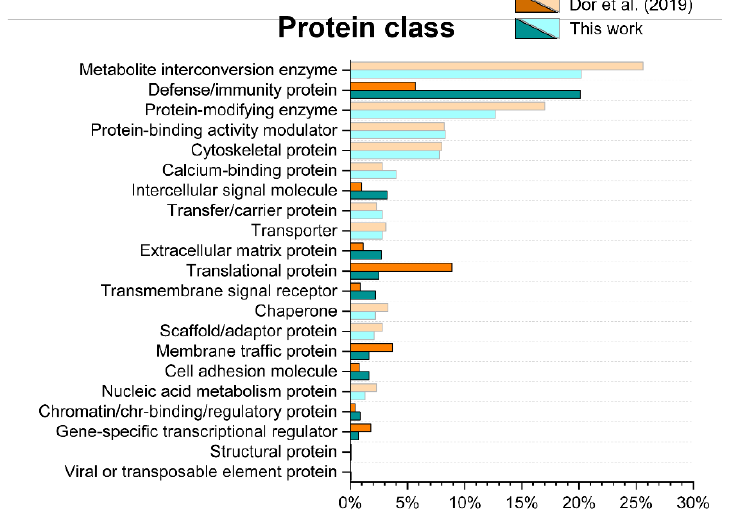
Figure 8. Bar charts of the protein classes obtained with the 890 proteins identified in this work, using the Protein Analysis Through Evolutionary Relationships (PANTHER) program. The results are compared with the protein list published by Dor and coworkers [15]. Protein classes displaying a log 2 (fold change) ≥|1| are highlighted by stronger saturated colors.